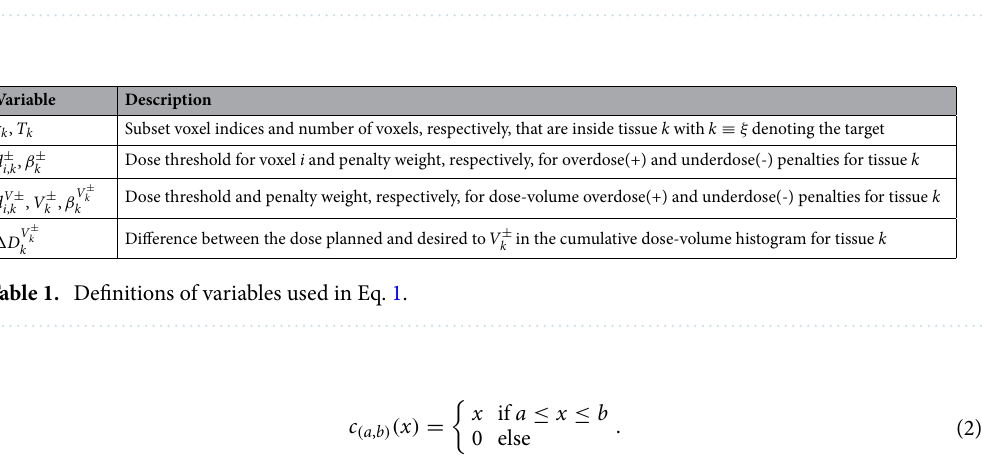
Figure 1. Algorithm flow chart of the arc-based treatment planning strategy used to optimize the DC-PAT treatments. The ploidy is defined by the number of energy layers per beam angle that are considered. A haploid system is presented above were each gantry angle has only a single energy assigned to it.